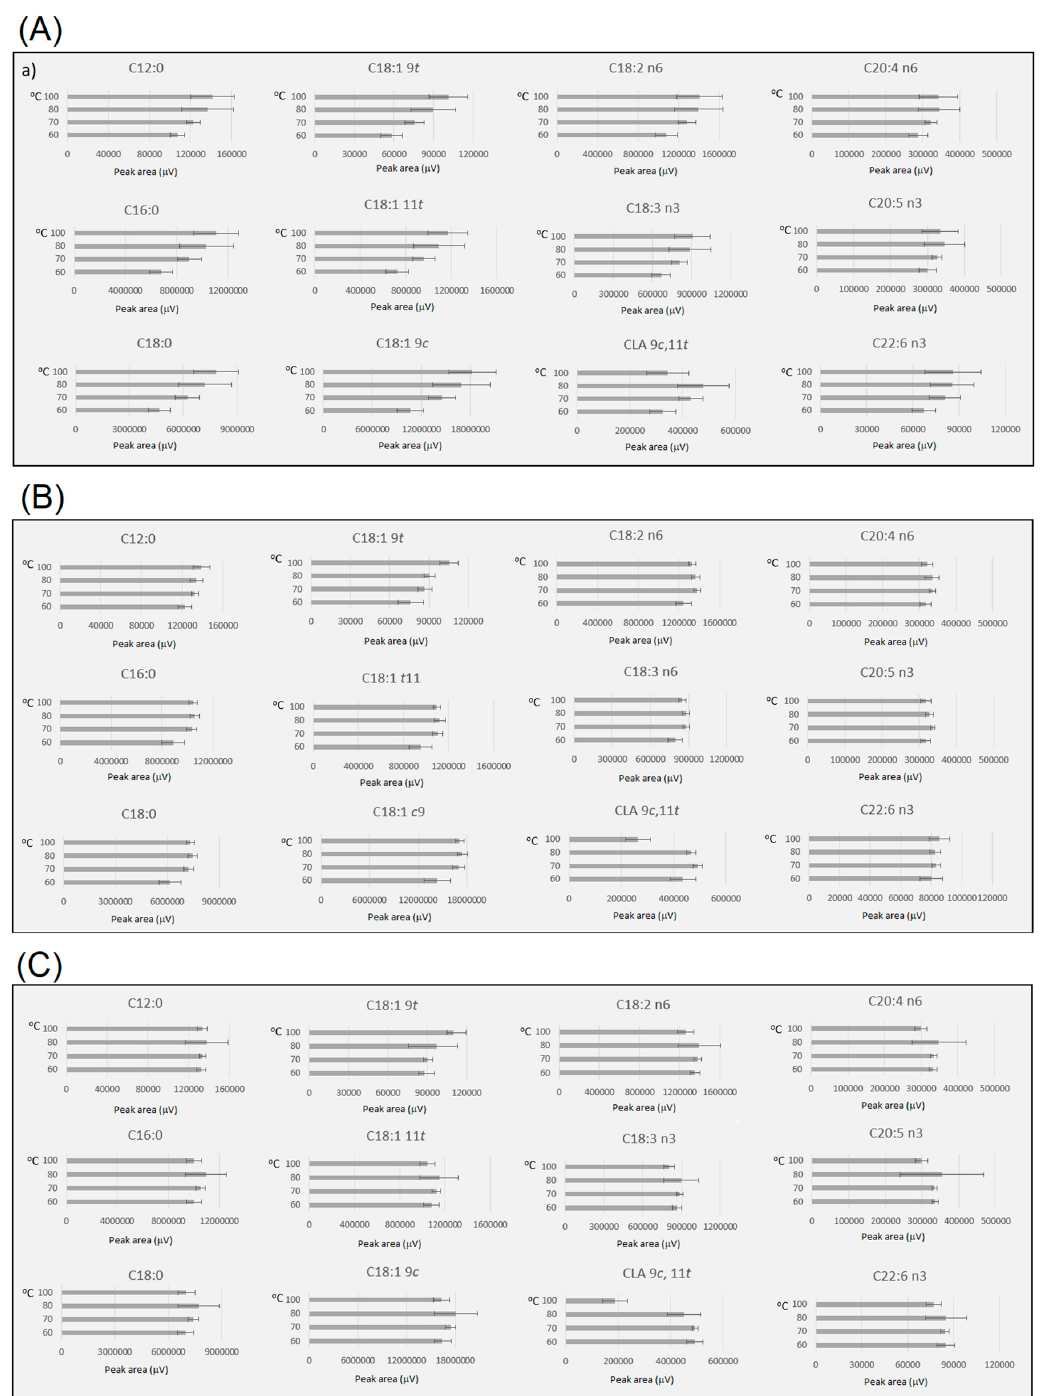
Figure 2. FAMEs yield (peak area normalised by volume of toluene and sample weight) comparison under different incubation temperatures and times ( a )—1 h, ( b )—2 h and ( c )—3 h. Samples with acid concentration range from 3 to 7, total solvent volume of 8 and 10 mL, mass range from 200 to 400 mg and moisture between 0 and 7.5% were included to obtain the mean and standard deviation under the different conditions monitored. All experiments contained at least three replicates. For details, see Table S1.